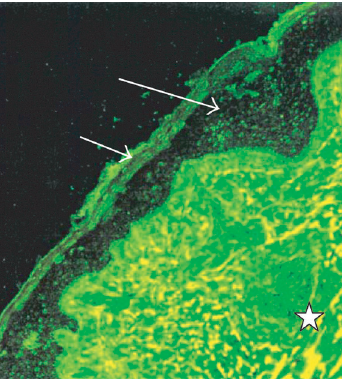
Figure 1. Immunofluorescence micrograph of a section of hu- man skin stained with FITC using anti-decorin as the primary antibody (see “materials and methods”). The epidermis falls into two parts, with the outer more cornified cells showing some nonspecific labelling (small arrow), whereas the main part of the epidermis is essentially devoid of staining (large arrow). The dermis is well delineated and is progressively richer in decorin towards its internal aspect (star). Original magnification × 240.